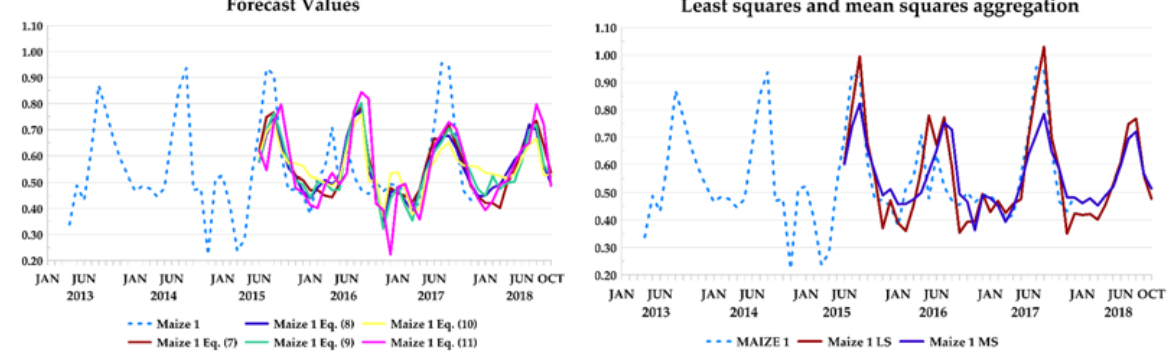
Figure 4. Forecast values for one-year time horizon given by the estimation models presented in Equation (7)–(11) and least squares and mean squares aggregation models.